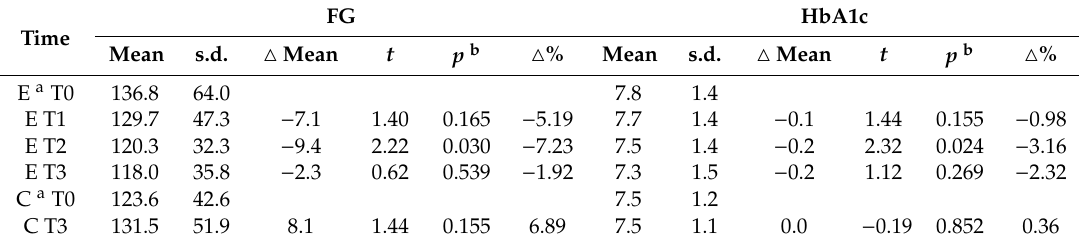
Table 4. Changes in FG and HbA1c before and after